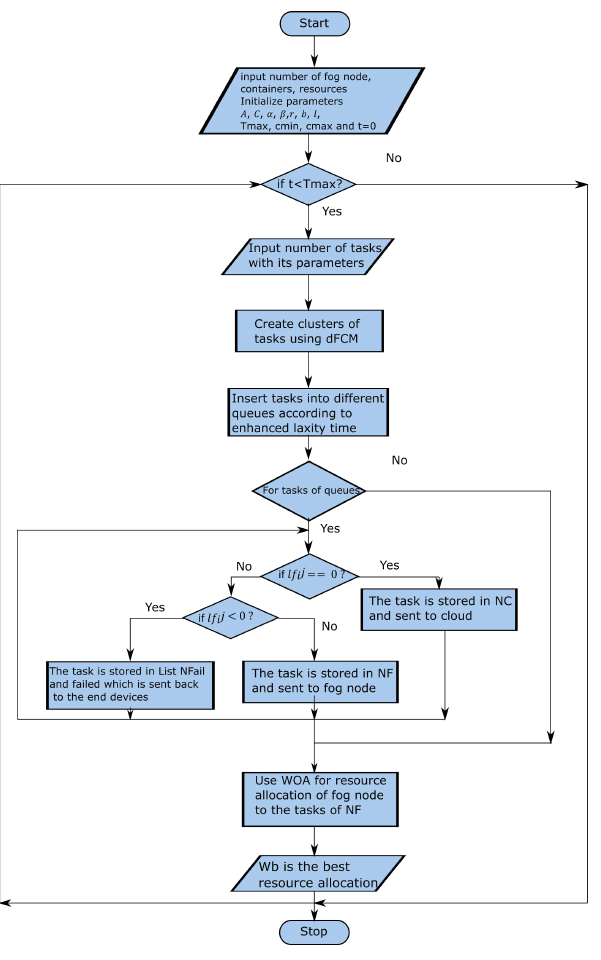
Figure 5. Flowchart of the algorithm.